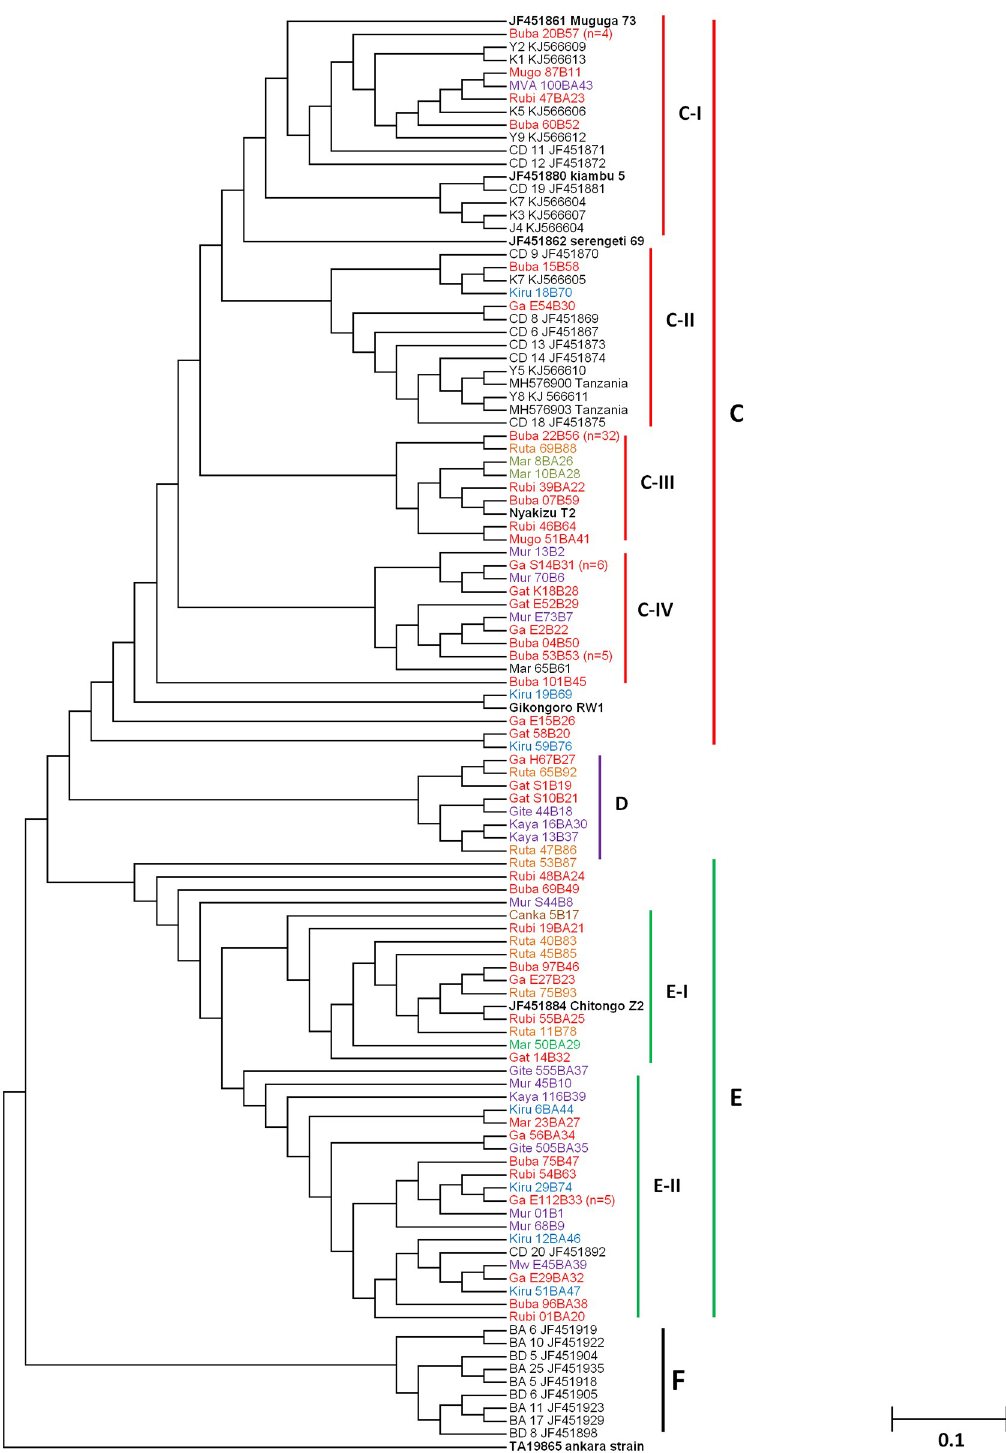
Fig 5. Theileria parva CTL Tp2 neighbour joining phylogenetic tree generated from 531 bp nucleotide sequences. MEGA ver. 6 with a confidence level of 1000 bootstrap replicates was used to generate the phylogenetic tree. Samples from the Northern, Southern, Eastern, Western, Central and North Eastern regions are given in blue, black, orange, yellow, purple and brown colour codes. Only a single sequence was used to represent sequences that shared 100% homology.